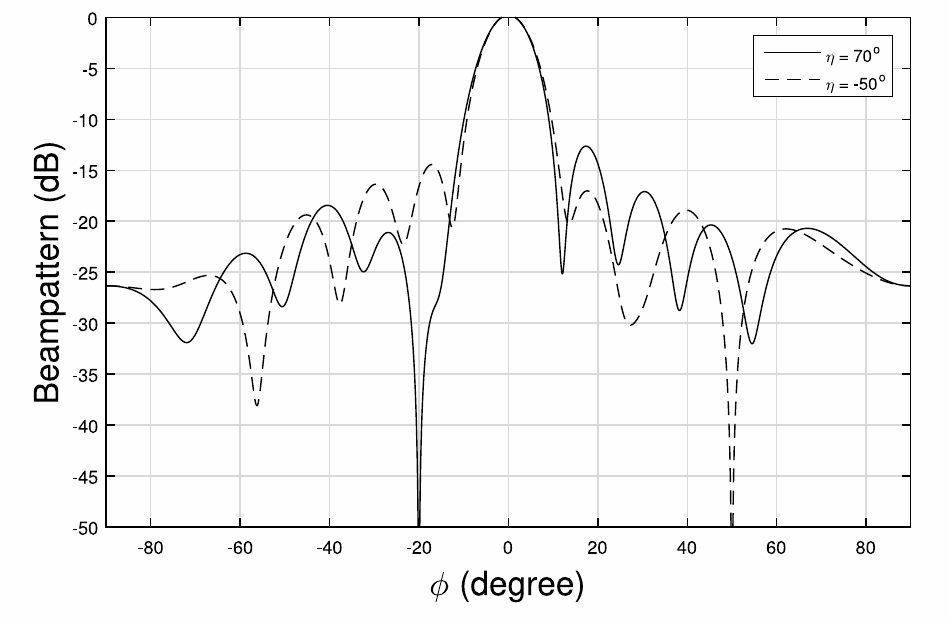
Figure 4. The resultant beam pattern for (1) θ = 90 ◦ , γ = 60 ◦ , η = 70 ◦ ; (2) θ = 90 ◦ , γ = 60 ◦ , η = − 50 ◦